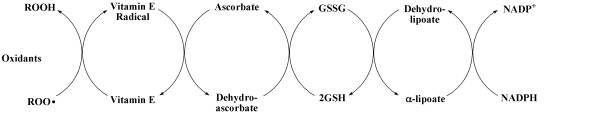
Cellular responses to oxidant exposure. ROOH and ROO• indicate lipohydroperoxide and its oxygen centered organic radicals formed by radical reactions with cellular components, respectively. GSH and GSSG represent the sulfhydryl/disulfide pair of glutathione species. Nicotinamide adenine dinucleotide phosphate, NADP(H), is the primary electron source, regenerated by the cellular reduction systems.